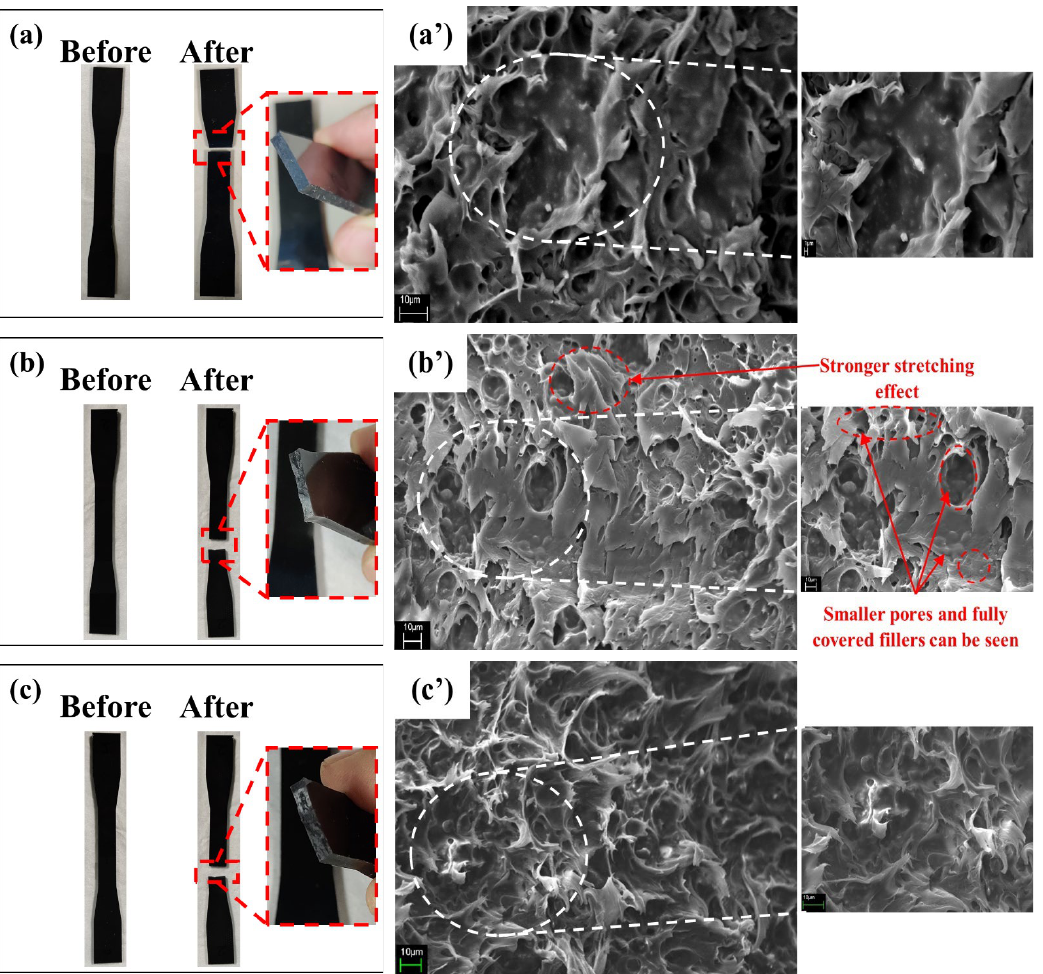
Figure 4. Macroscopic images before and after tensile test and SEM micrographs of ( a , a’ ) NC, ( b , b’ ) T1 and ( c , c’ ) T2 nanocomposites, respectively. Note: NC represents a nanocomposite with no com- patibilizer, T1 represents a nanocomposite with MAH compatibilizer (MAH/GnP 1:1) prepared by the two-step method, and T2 represents a nanocomposite with MAH compatibilizer (MAH/GnP 1:1) and DCP via the one-pot method.